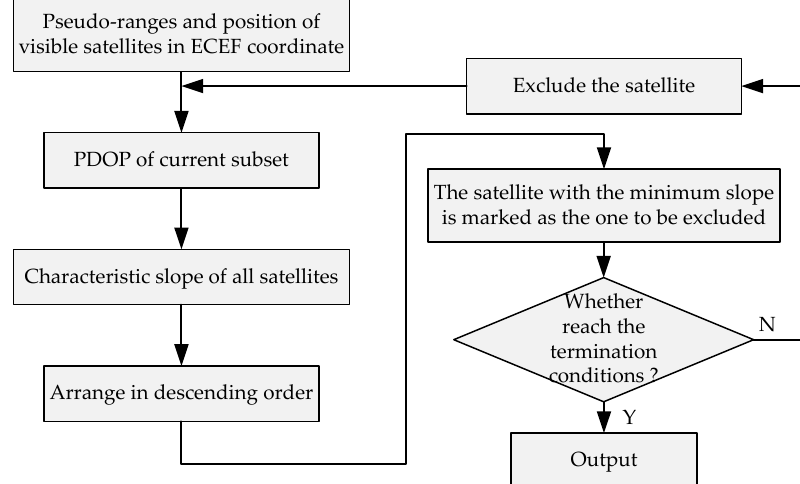
Figure 5. Flow chart of subset selection method based on the characteristic